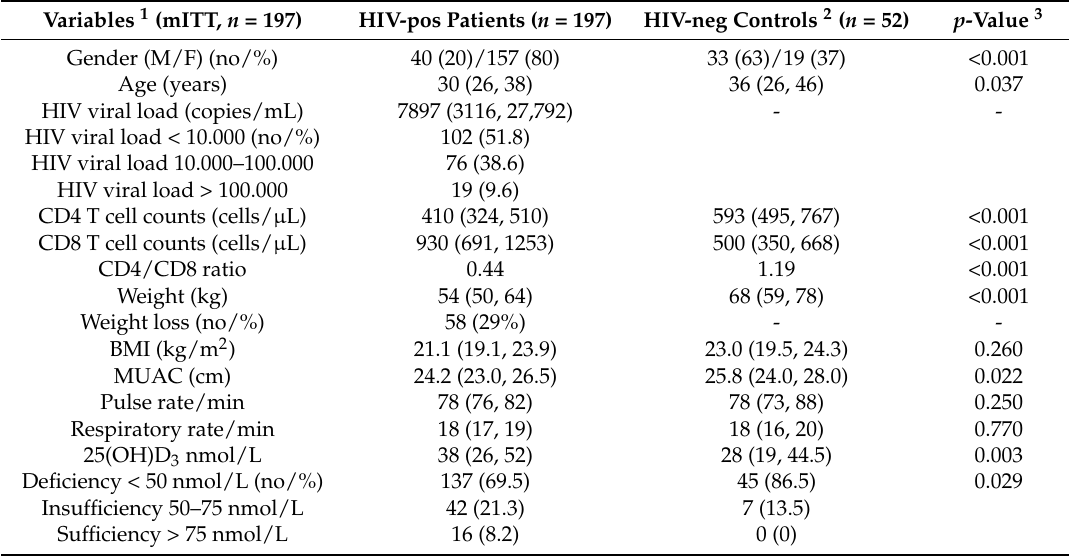
Table 1. Baseline characteristic in HIV-positive patients versus HIV-negative controls.